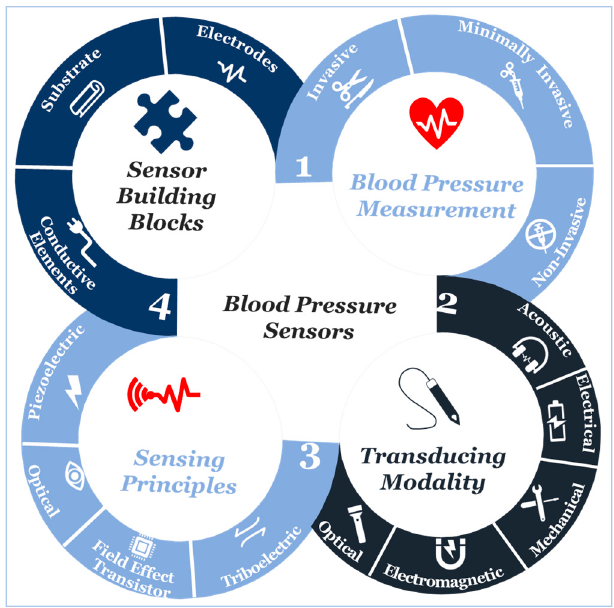
Figure 1. The transdisciplinary approach for the comprehensive review of the recent development in biomaterials used for an accurate yet continuous blood pressure